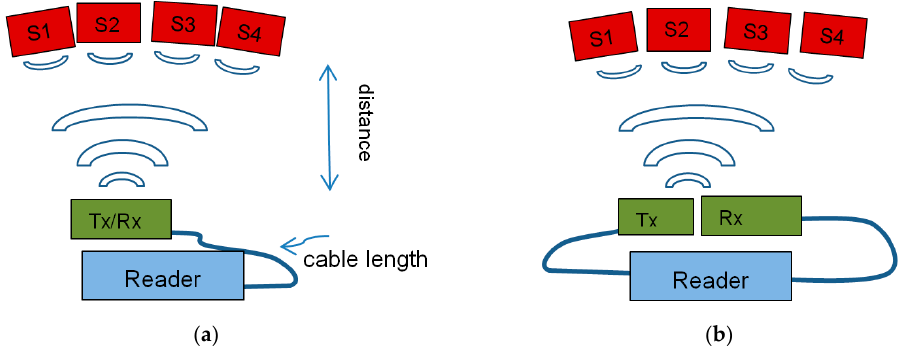
Figure 8. Symbolic drawing of the test setup for ( a ) single antenna and ( b ) two-antenna setup. Tx is the emitting antenna, Rx the receiving one.